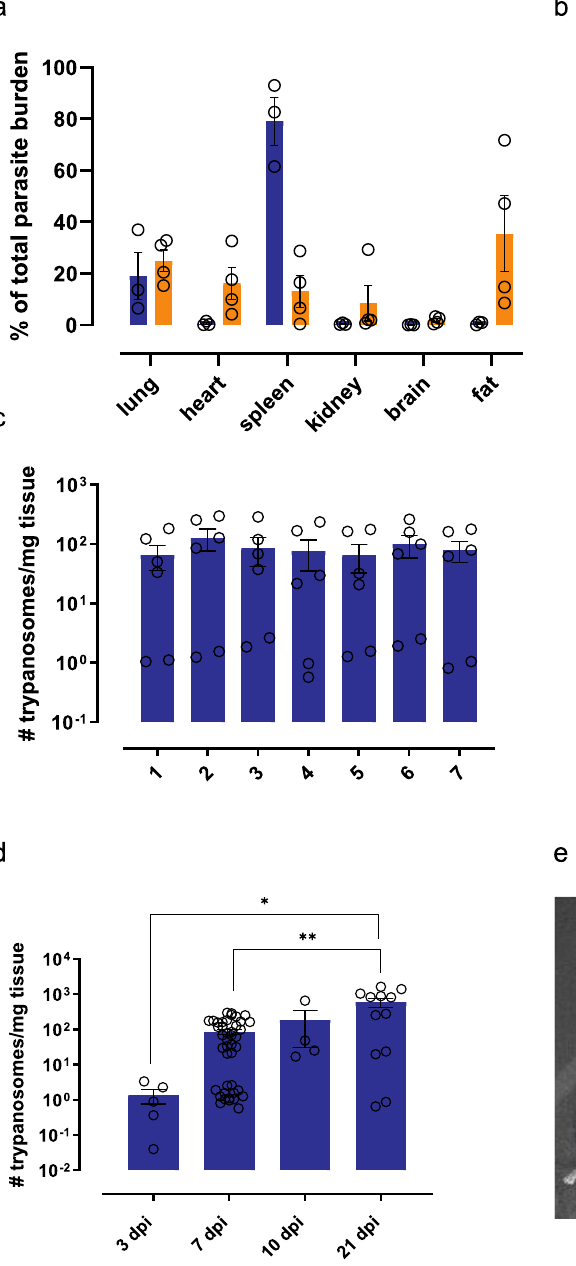
curve. Created with BioRender.com. d Parasite burdens in the lungs at different time points during infection (3 dpi: n =3, 7 dpi: n =21, 10 dpi: n =4, 21 dpi: n =6). Statistical comparisons were made using Kruskal – Wallis test (two-sided) with